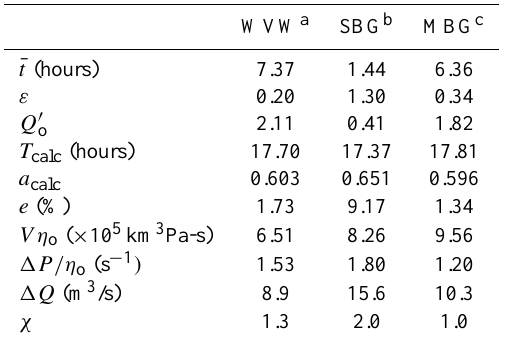
Table 2. Values of the parameter ε and the time scale ¯ t leading to a minimum in the error function e of Eq. (55) for various bubble growth models. Here, T obs =18h and a obs =0.6. The dimensionless reservoir flow rate Q 0 o is calculated from Eq. (22) with the knowl- edge of ¯ t and assuming Q o =10m 3 /s. Also, T calc = ¯ tT 0 product V η o is estimated from Eq. (22) with the knowledge of ¯ t and ε , and assuming Y =3 × 10 10 Pa and σ =0.2. 1P is the amplitude of the overpressure drop over one cycle. 1Q is the corresponding flow rate amplitude. χ is defined in Eq.